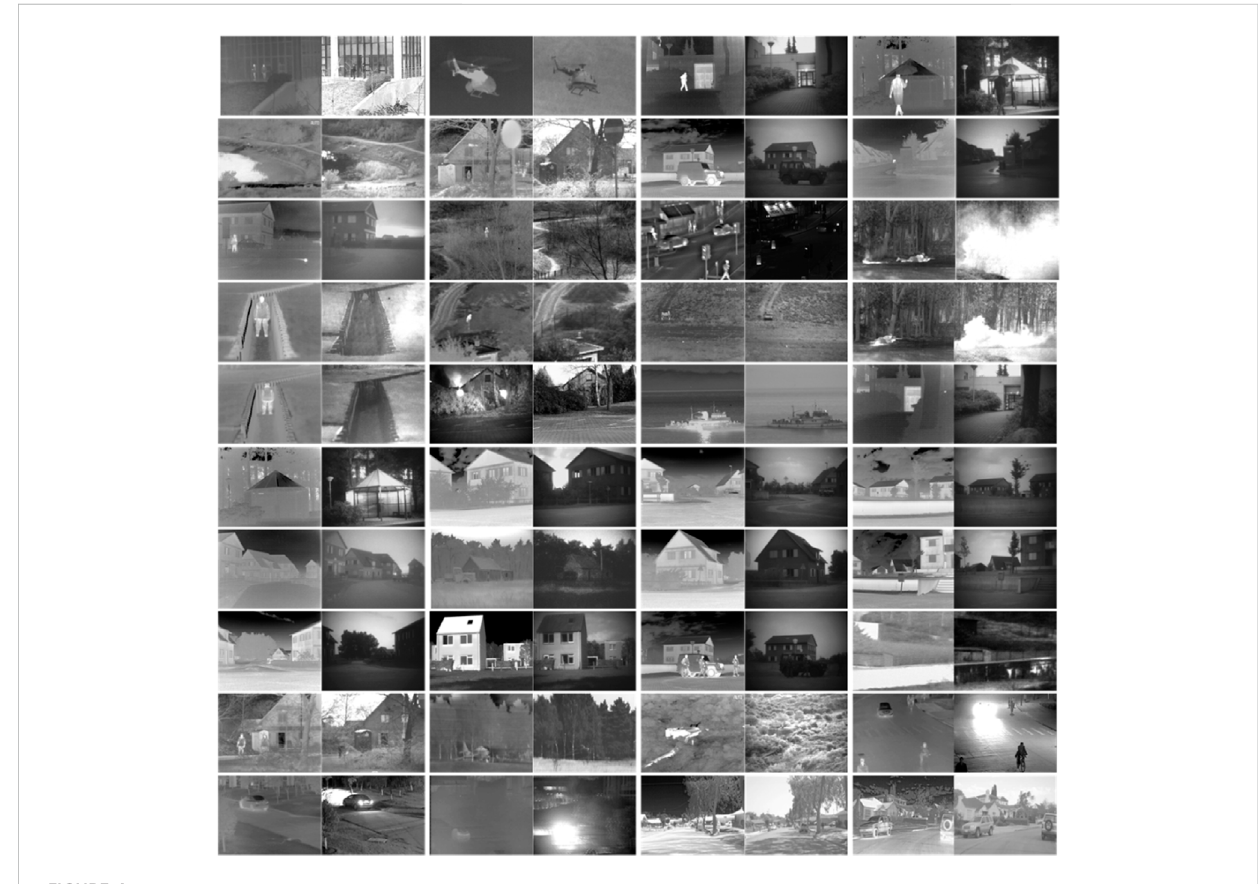
FIGURE 4 Some test images from TNO, VOT2020-RGBT and RoadScence datasets.